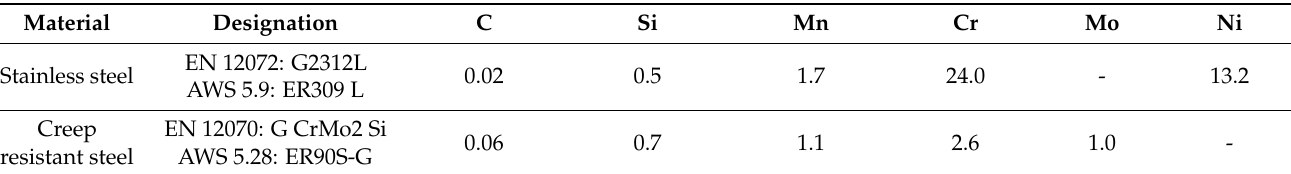
Table 1. Chemical composition of the filler materials